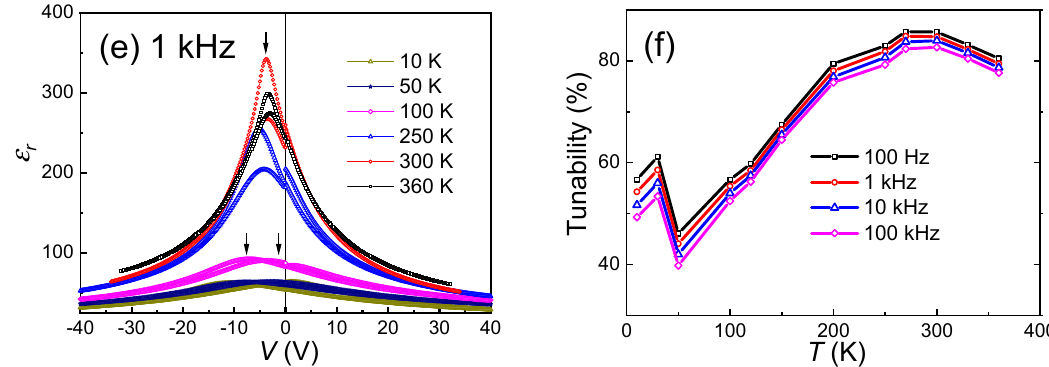
Figure 7. The temperature- and frequency-dependent ε r ( V ) curves and calculated tunability values: ( a ) the ε r ( V ) curves at di ff erent frequencies measured at 50 K; ( b ) tunability values at 50 K; ( c ) the ε r ( V ) curves at di ff erent frequencies measured at 300 K; ( d ) tunability values at 300 K; ( e ) the temperature-dependent ε r ( V ) curves measured from 10 K to 360 K at 1 kHz; ( f ) the tunability values as a function of temperature from 10 K to 360 K, measured at a frequency range from 100 Hz to 100 kHz.